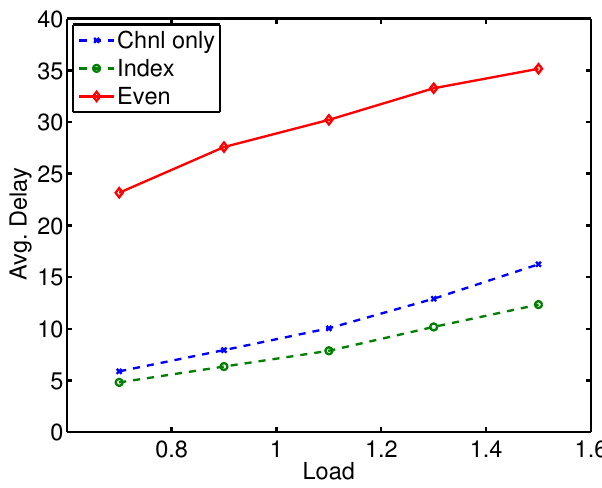
Figure 1. Average Delay when Index Policy Objective is Minimizing Average Delay, Synthetic Trace